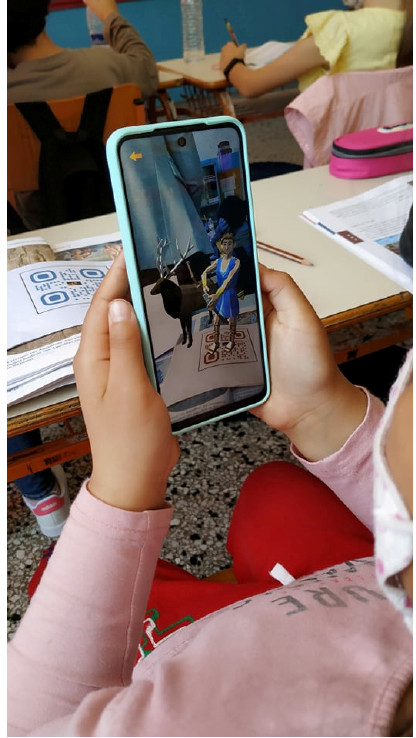
Figure 5. Testing of the app from a student in the class.